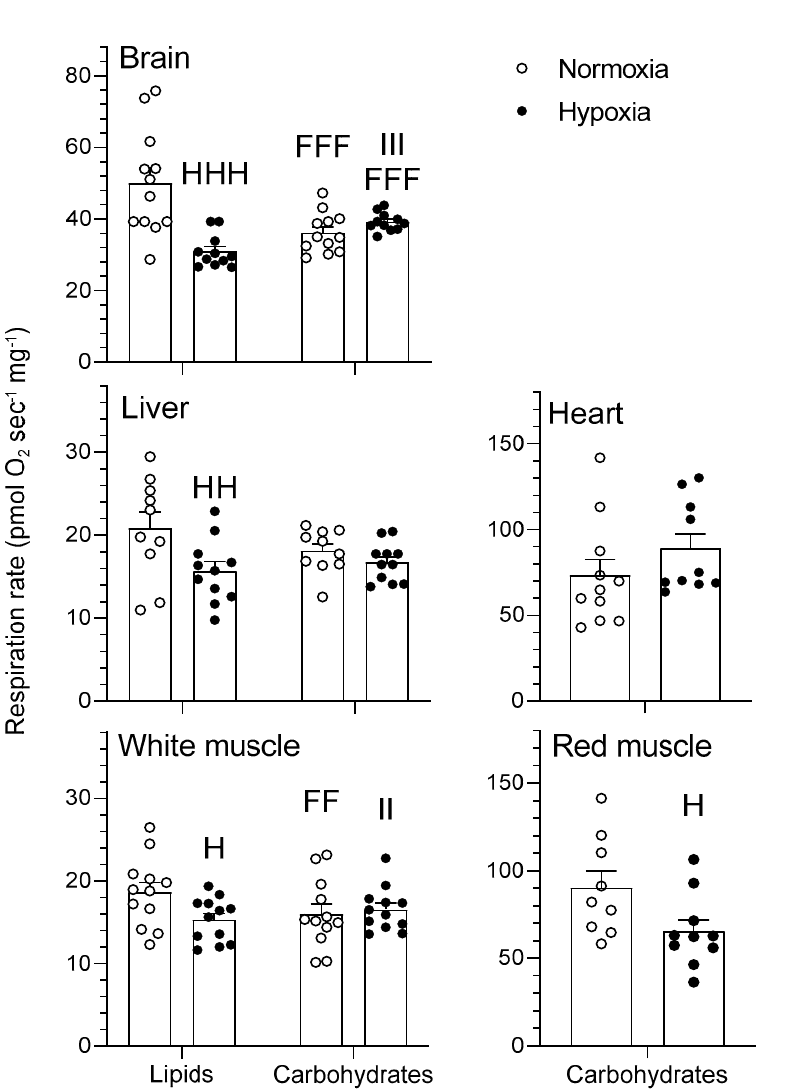
Figure 5. Mitochondrial oxidative fuel preference of COX in brain, liver, and white muscle of normoxic controls ( N = 12) and hypoxia-acclimated goldfish ( N = 11). COX respiration represents mitochondrial respiration following addition of ascorbate and a titration of N,N,N (cid:48) ,N (cid:48) -tetramethyl-p- phenylenediamine (TMPD) in the presence of pyruvate/malate + ADP + glutamate + succinate + cytochrome c + CCCP + antimycin A for the carbohydrate protocol and palmitoylcarnitine/malate + ADP + cytochrome c + CCCP + antimycin A for the lipid protocol. Values are means ± s.e.m. Dots represent individual data points. Differences between fuels are indicated as FF ( p < 0.01) and FFF ( p < 0.001). Differences between oxygen levels are indicated as H ( p < 0.05), HH ( p < 0.01), and HHH ( p < 0.001). Significant interactions between type of fuel and oxygen are indicated as II ( p < 0.01) and III ( p <